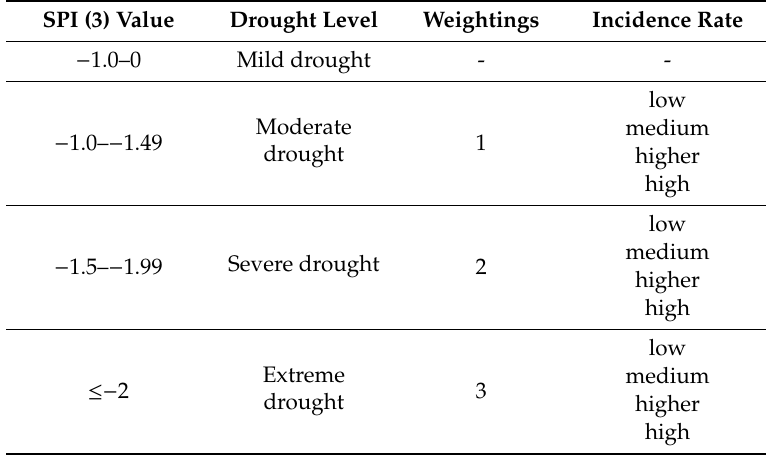
Table 3. SPI (3) and classification of drought